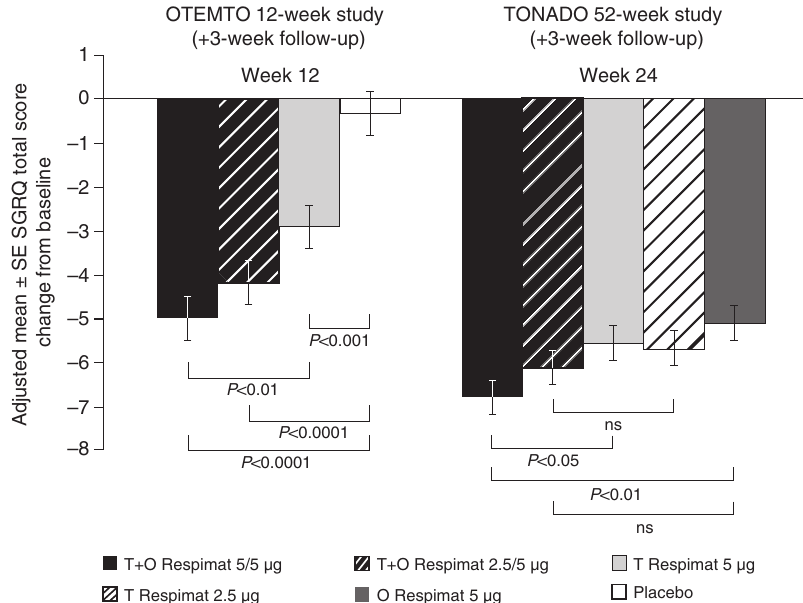
Fig. 4 Change from baseline in adjusted mean SGRQ total score after 12 weeks of treatment (OTEMTO) or 24 weeks of treatment (TONADO). O, olodaterol; SE, standard error; SGRQ, St George ’ s Respiratory Questionnaire; T,